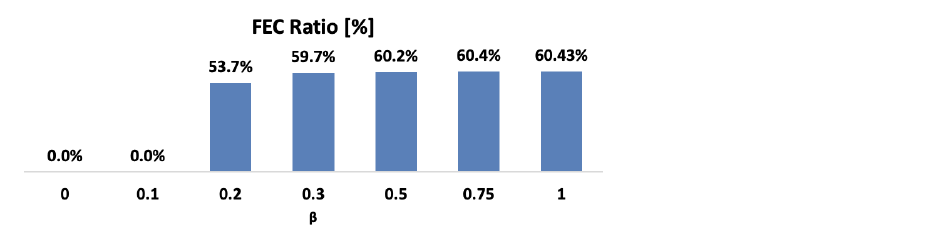
Figure 8. Efficient Frontier for the stochastic case.